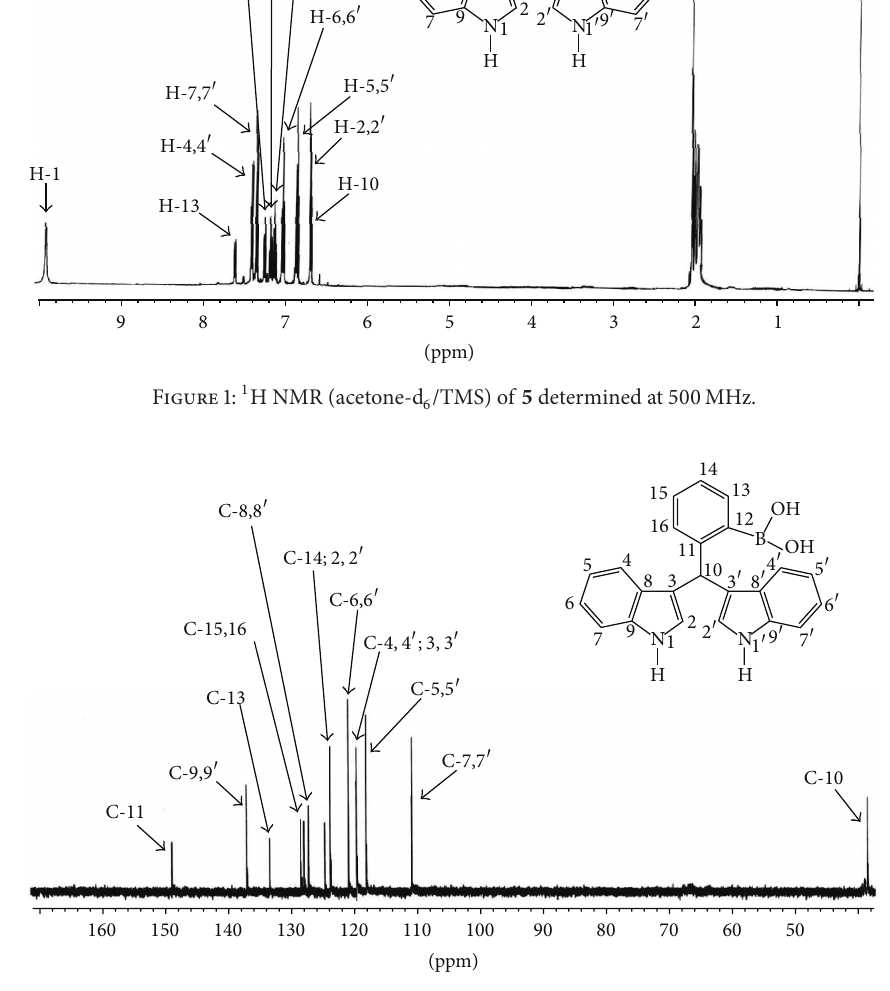
Figure 2: 13 C NMR (acetone-d 6 /TMS) of 5 determined at